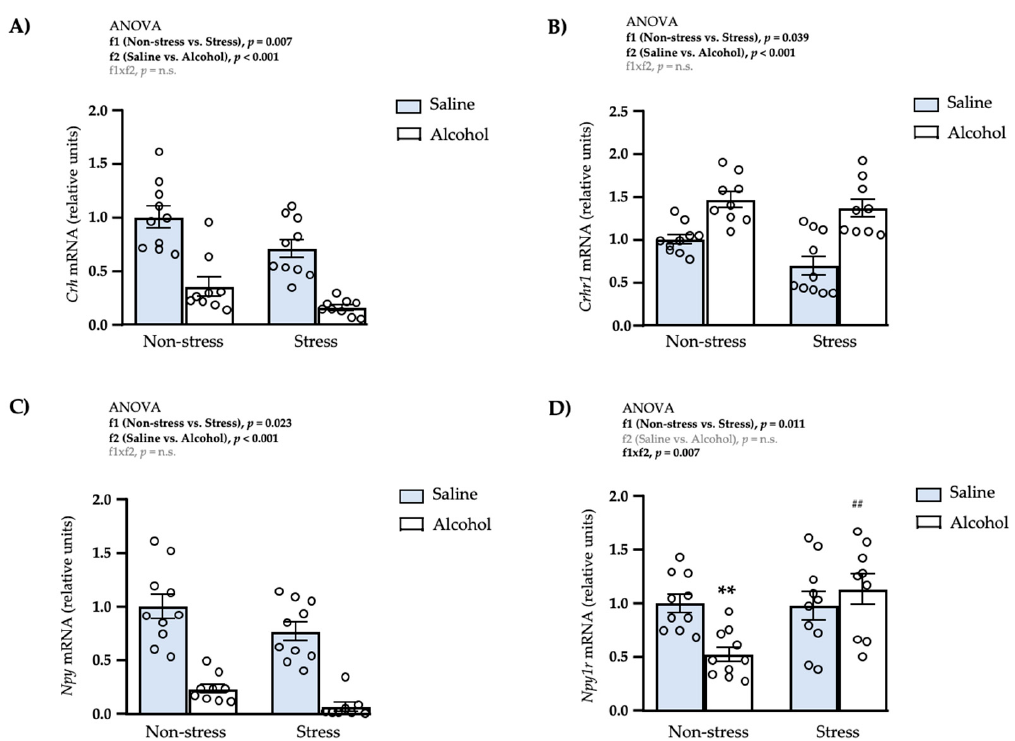
Figure 6. Relative mRNA expression levels of CRH and NPY systems in the amygdala of adult male rats after repeated restraint stress and/or intermittent alcohol exposure during adolescence. Relative mRNA expression of Crh ( A ); Crhr1 ( B ); Npy ( C ); and Npy1r ( D ) in male adult rats after repeated restraint stress (f1) and/or intermittent alcohol exposure (f2) during adolescence. Bars represent the mean ± SEM (9–10 rats/subgroup). Data were analyzed by two-way ANOVA. (**) q < 0.01 denotes significant differences compared with the non-stress saline subgroup and ( ## ) q < 0.01 denotes significant differences with the non-stress alcohol subgroup using post hoc tests for multiple comparisons when an interaction between factors is found (f1 × f2). P -values in bold denote significant main effects of factors (f1 and f2) or significant interaction (f1 × f2).